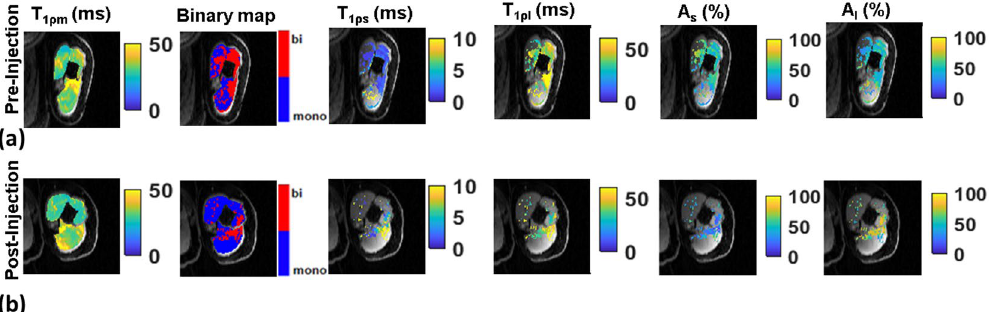
Figure 2. Bi-exponential T 1ρ mapping pre- and post-injection treatment. ( a ) shows the results in a patient pre- treatment ( b ) shows the same patient following hyaluronidase injections at approximately the same slices. Note changes in the shape of the muscle. In the biceps, note considerable reduction in T 1ρm values, and shift of T 1ρs and T 1ρl towards normative